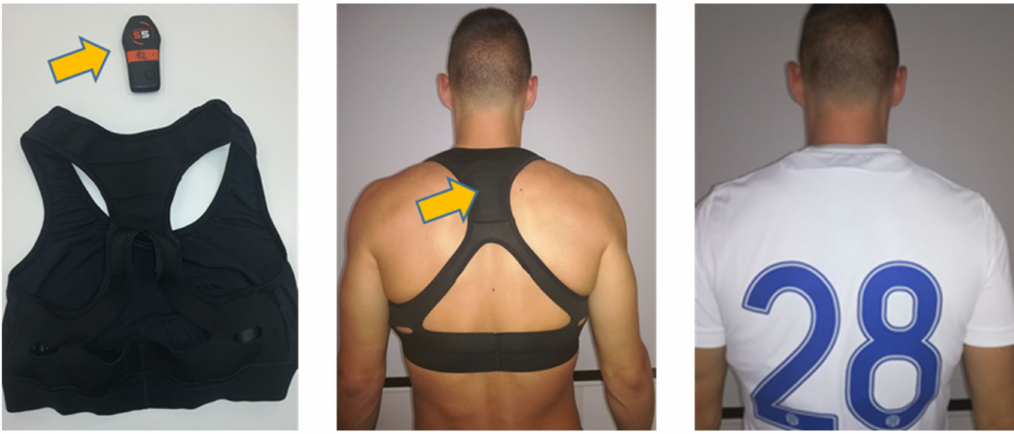
Figure 1. Global positioning device (GPS) used for the measurement of running performances in